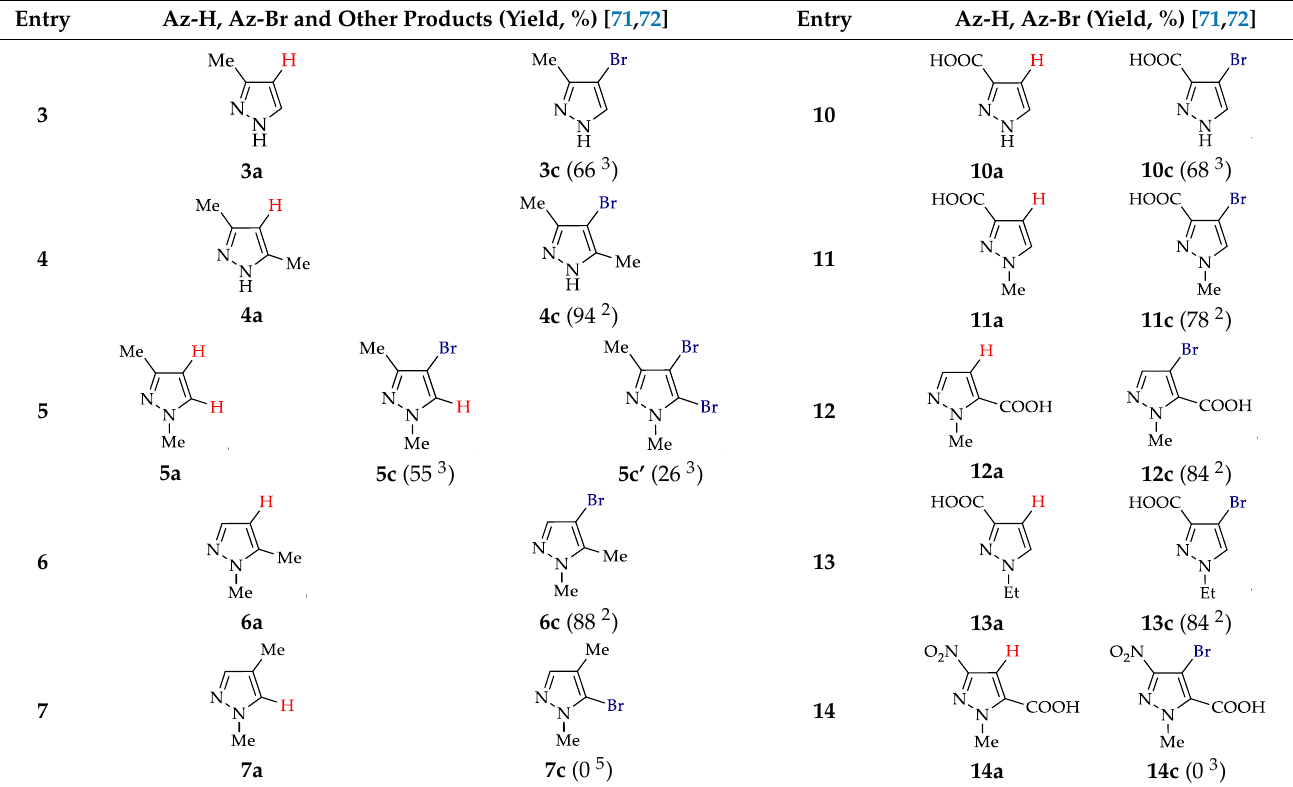
Table 2. C‒H An bromination of pyrazoles (Az‒H) 1 .